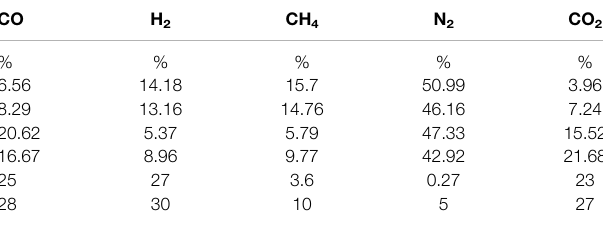
TABLE 3 | The biogas composition under different CO 2 volume